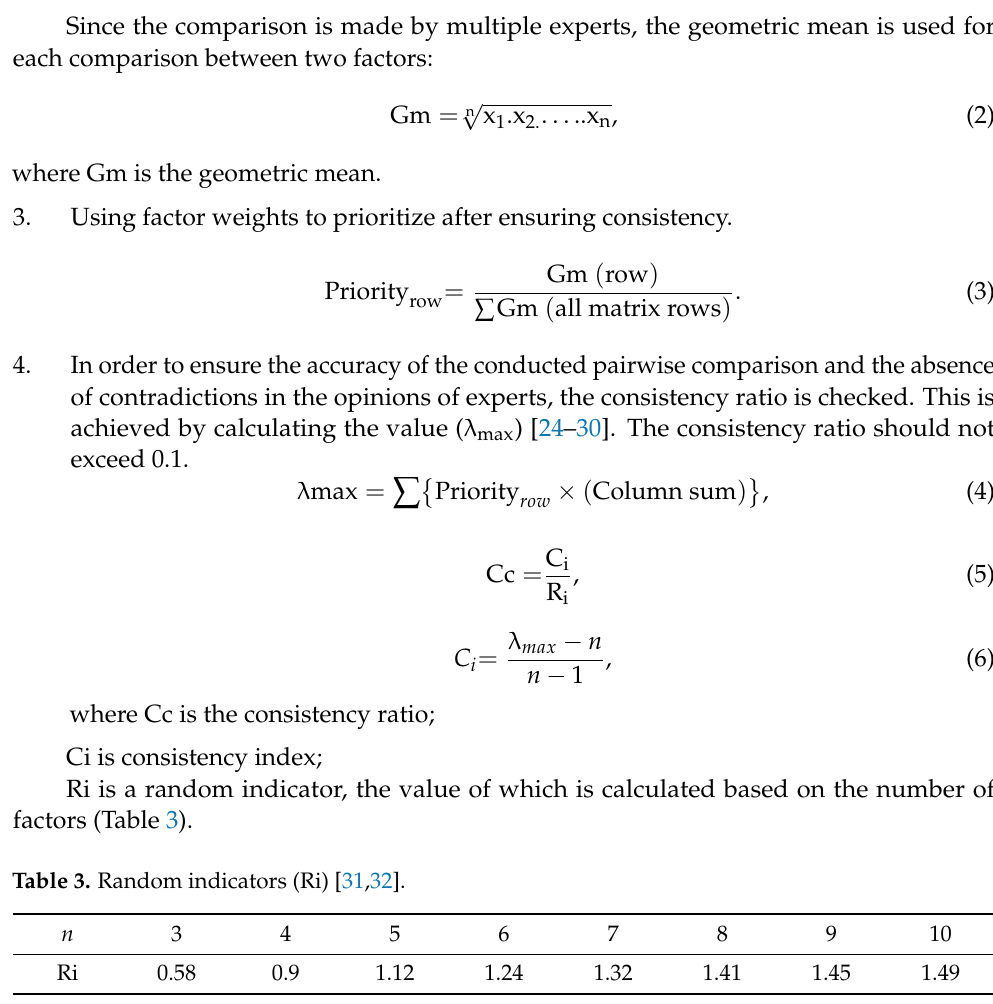
Averages used between previous weights